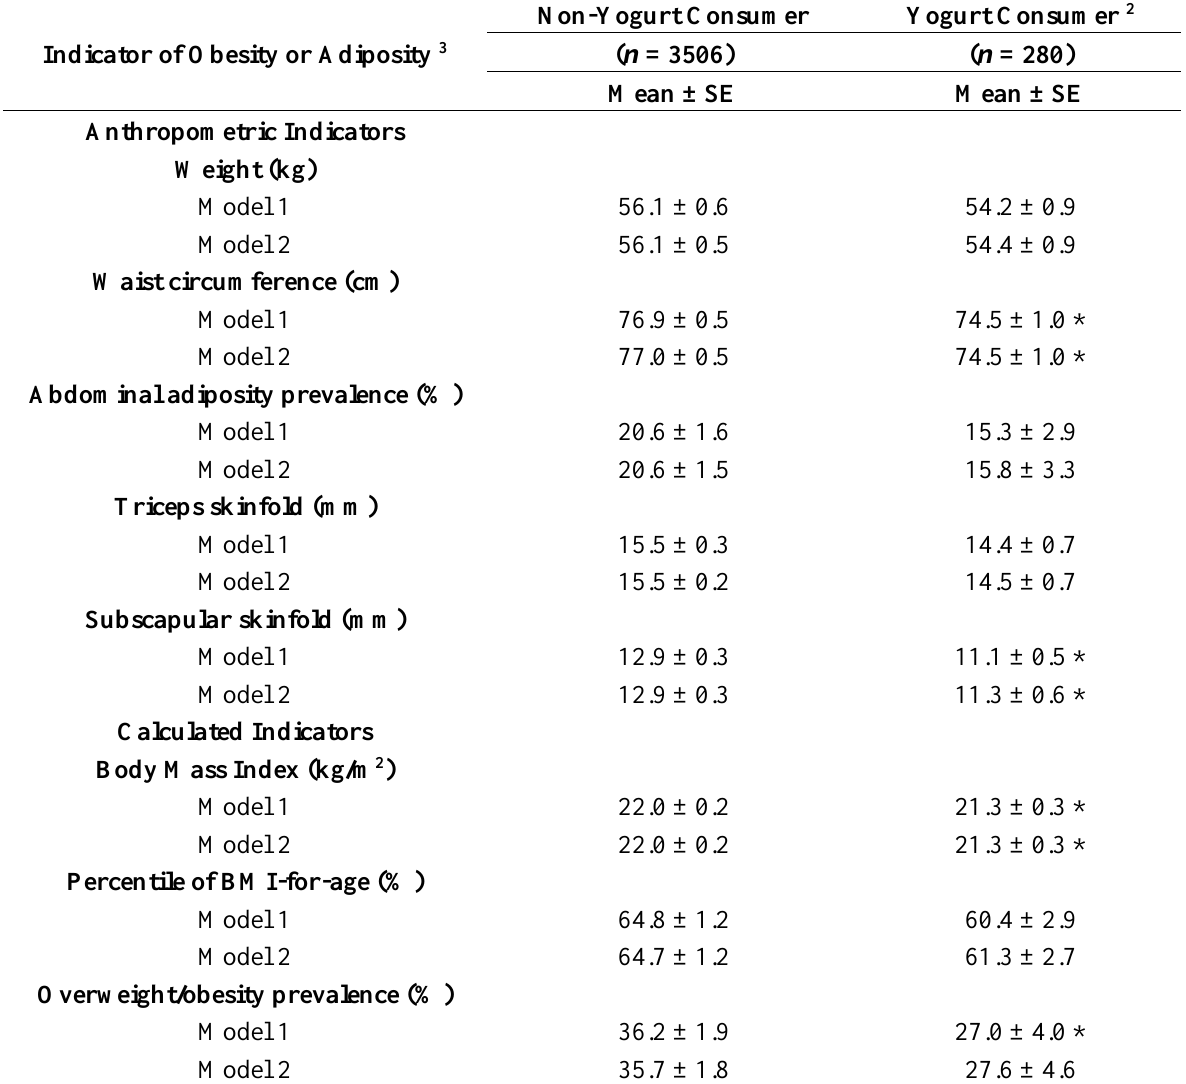
Table 3. Covariate-adjusted mean value of obesity or adiposity indicator by yogurt consumption groups 1